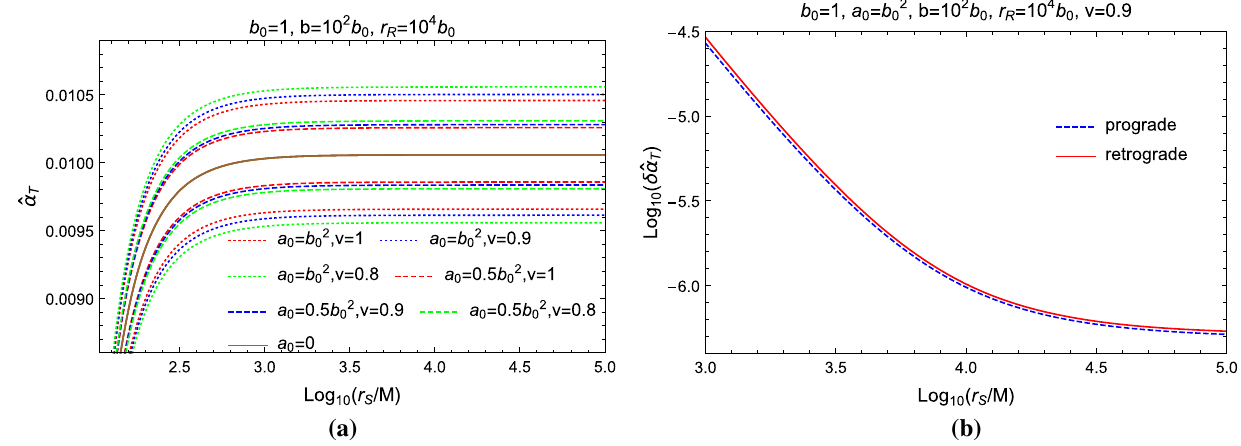
Fig. 4 The finite-distance deflection angle of massless and massive particles in Teo wormhole spacetime. a The deflection angle, Eq. (68). The lines above the a 0 = 0 lines are for retrograde motion and the lines below are for retrograde motions. b The finite distance correction, Eq.